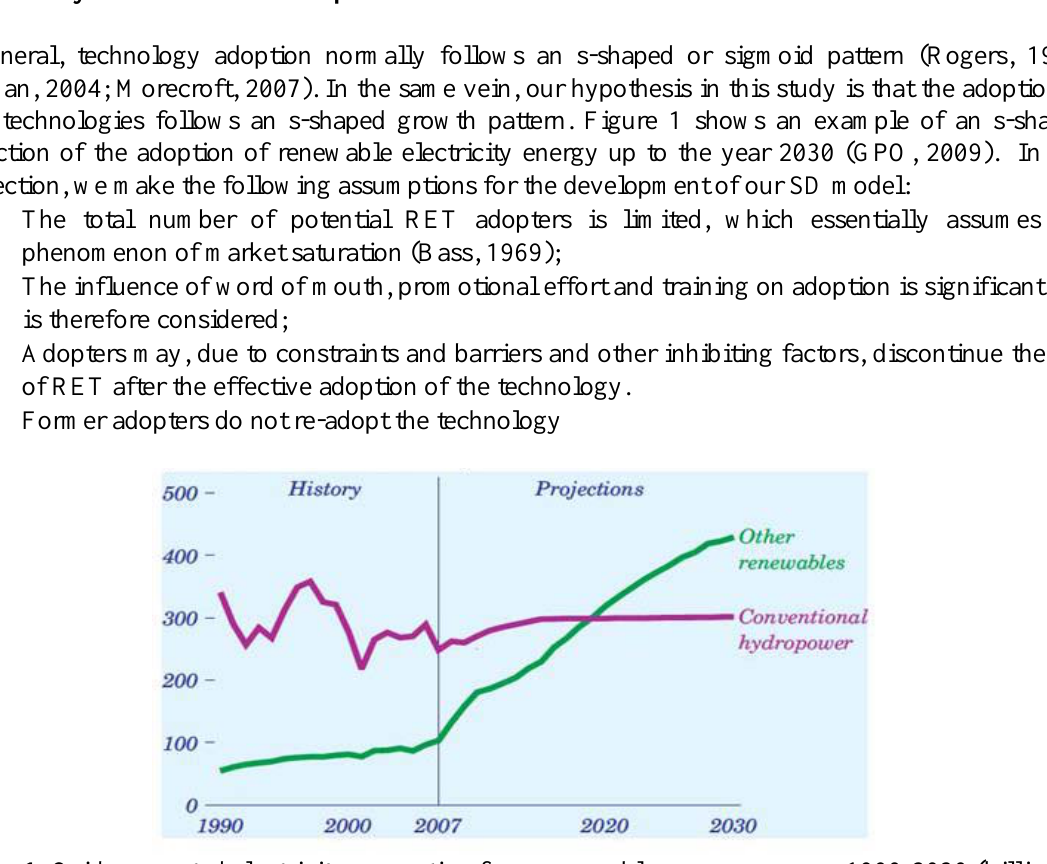
Fig. 1. Grid connected electricity generation from renewable energy sources, 1990-2030 (billion kilowatts) (GPO,